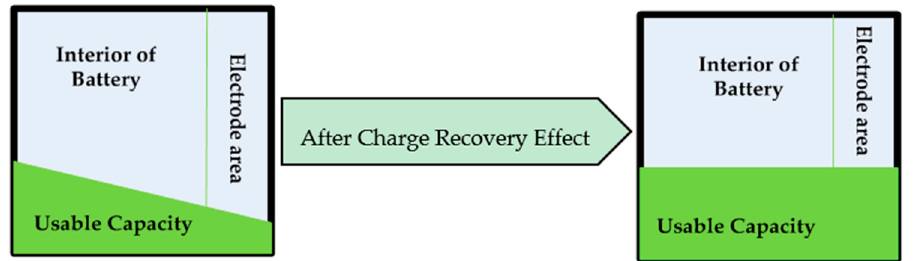
Figure 5. Demonstration of charge recovery effect.